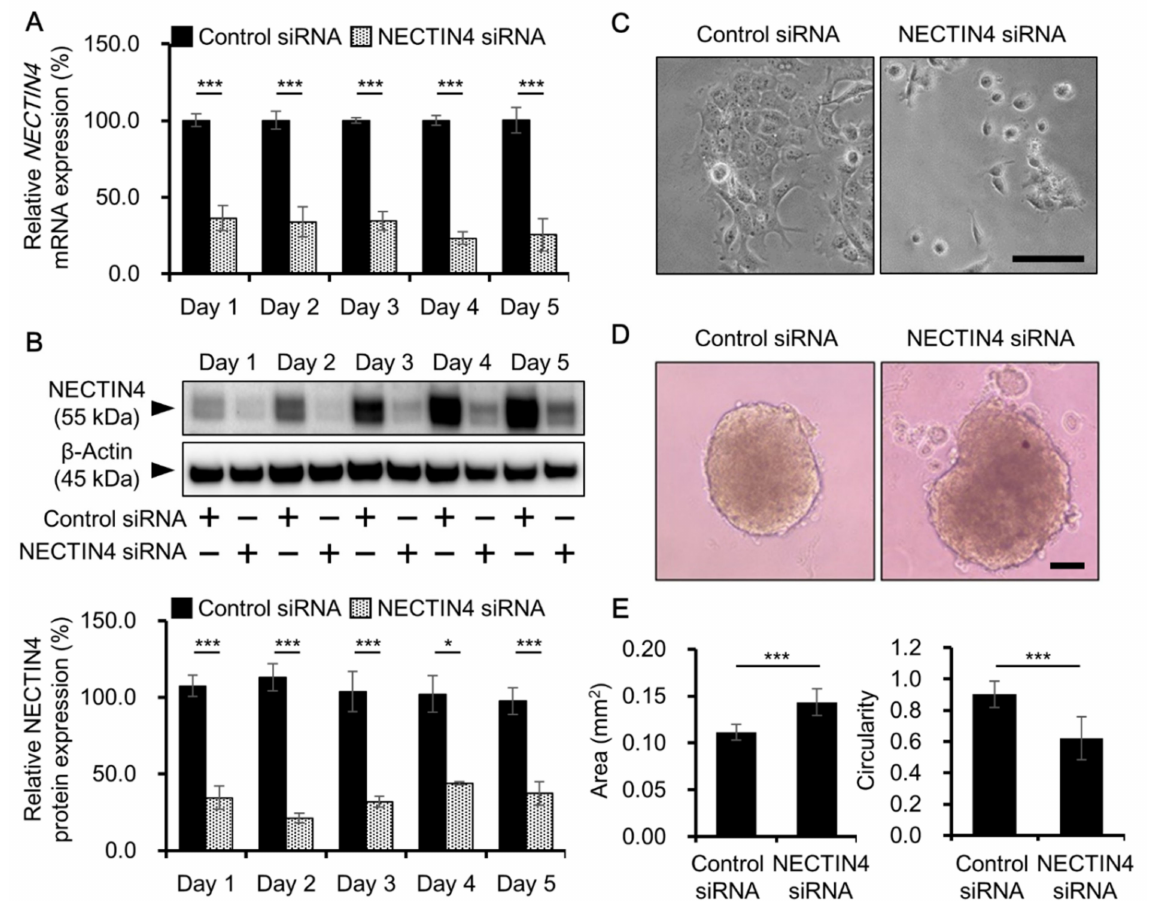
Figure 3. Effects of NECTIN4 inhibition on the adhesion of A431 cells. ( A , B ) NECTIN4 was inhibited in A431 cells by siRNA transfection. The efficiency of NECTIN4 knockdown at the mRNA ( A ) and protein ( B ) levels is shown on days 1–5 after siRNA transfection. Data are the mean ± SD ( n = 3). ( C ) Representative microscopic images of control or NECTIN4 siRNA-transfected cells. Scale bars = 100 µ m. ( D ) Representative images of spheroids derived from control or NECTIN4 siRNA-transfected A431 cells. ( E ) Area (left) and circularity (right) of spheroids derived from control or NECTIN4 siRNA- transfected A431 cells. Spheroid formation was independently repeated three times and evaluated in six wells per condition. Data are the mean ± SD. * p < 0.05, *** p <